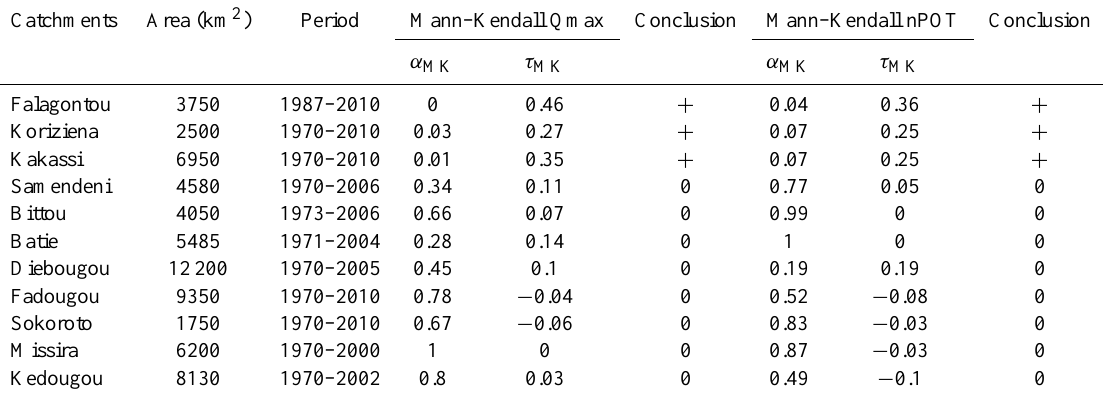
Table 5. Results of Mann–Kendall trend test on Qmax and nPOT time series for the 11 shorter time series: “ + ” for significant positive trend; “–”for significant negative trend; “0” for no significant trend.